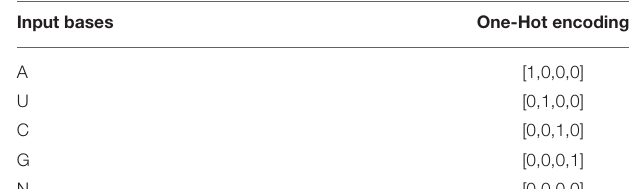
TABLE 1 | The rules of transformation between bases and One-Hot vectors.